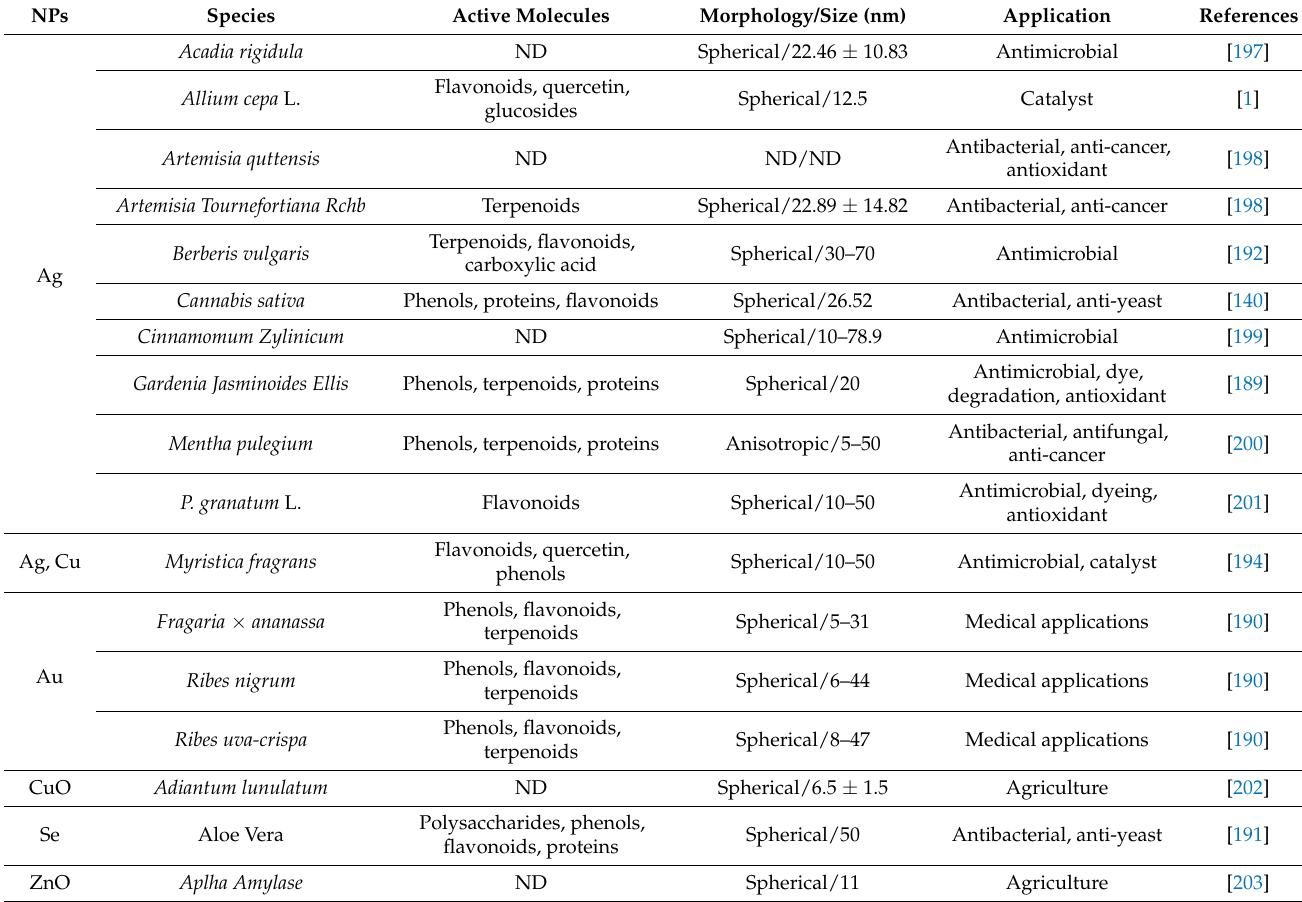
Table 5. Nanoparticles produced by plant